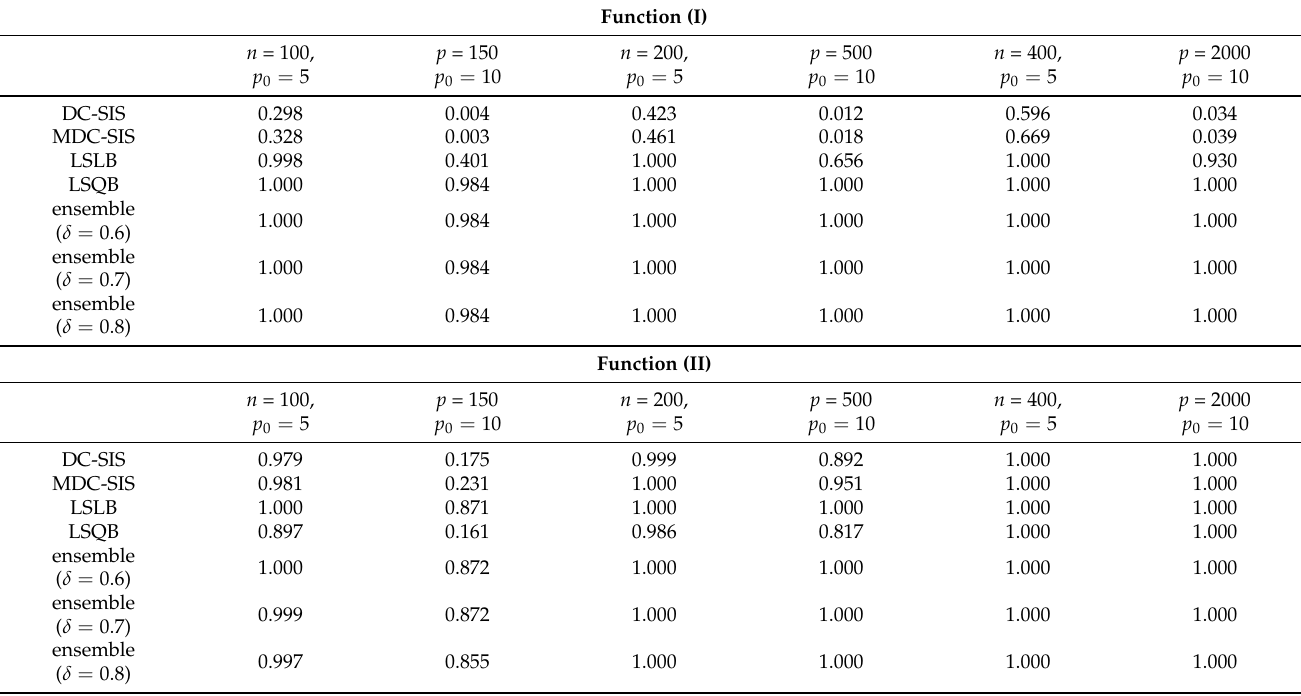
Table 1. Coverage rates in